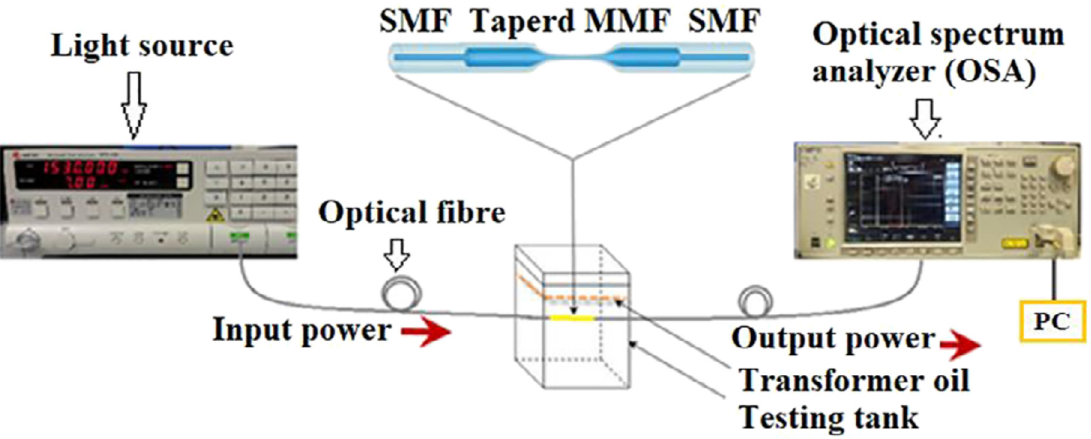
Figure 13. Experimental configuration [10].